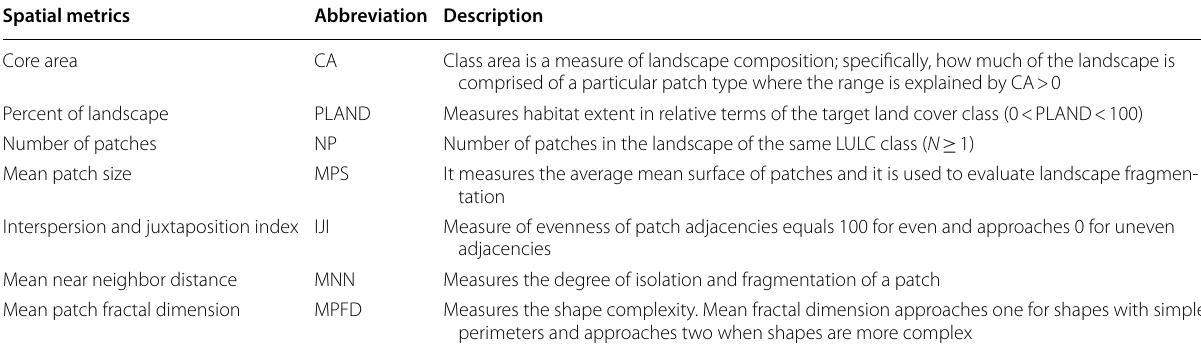
Table 2 Selected landscape metrics following the definitions of McGarigal and Ene (2012) Spatial